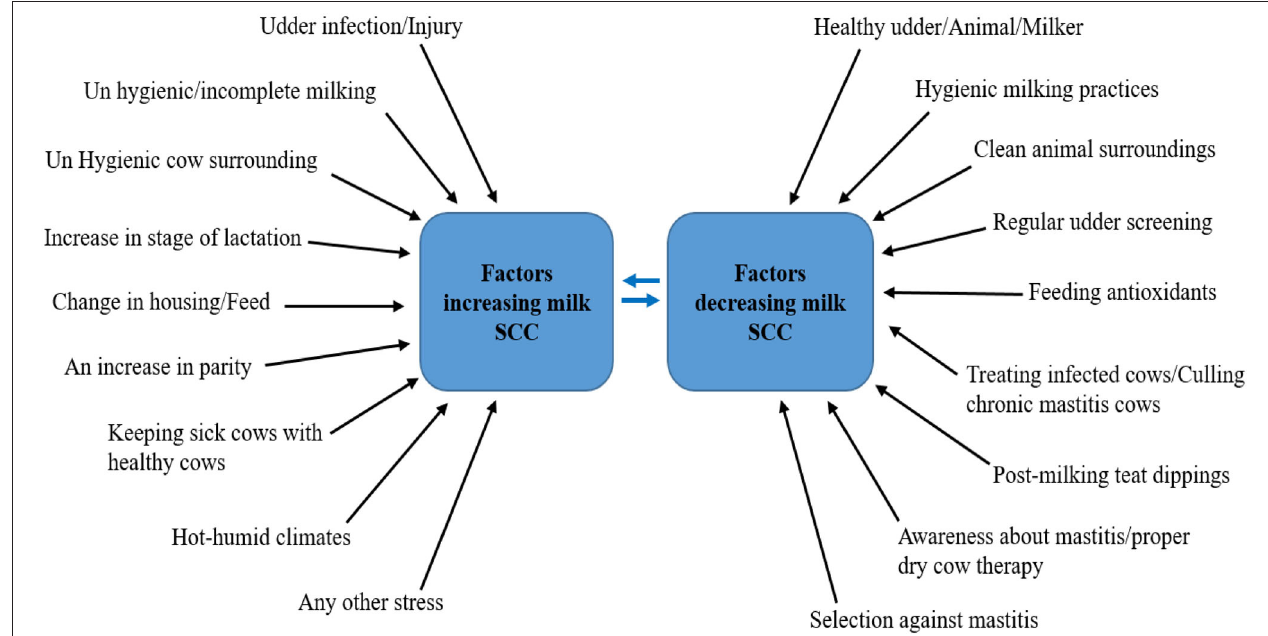
FIGURE 3 | Factors and management practices affecting the release of milk SCC. Source: Adapted from Alhussien and Dang (49).